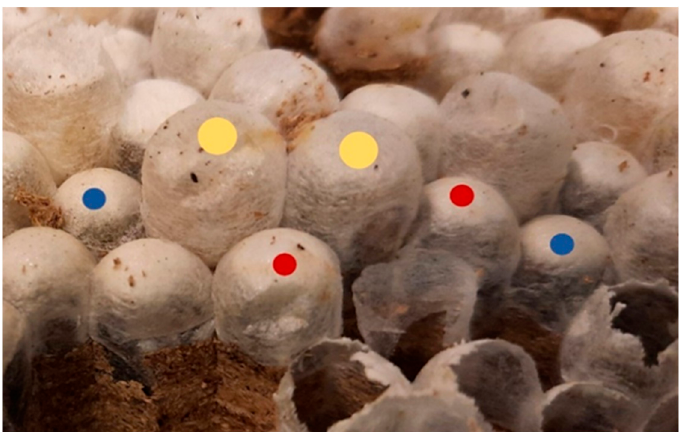
Figure 6. Two eggs per cell in different declining nests.